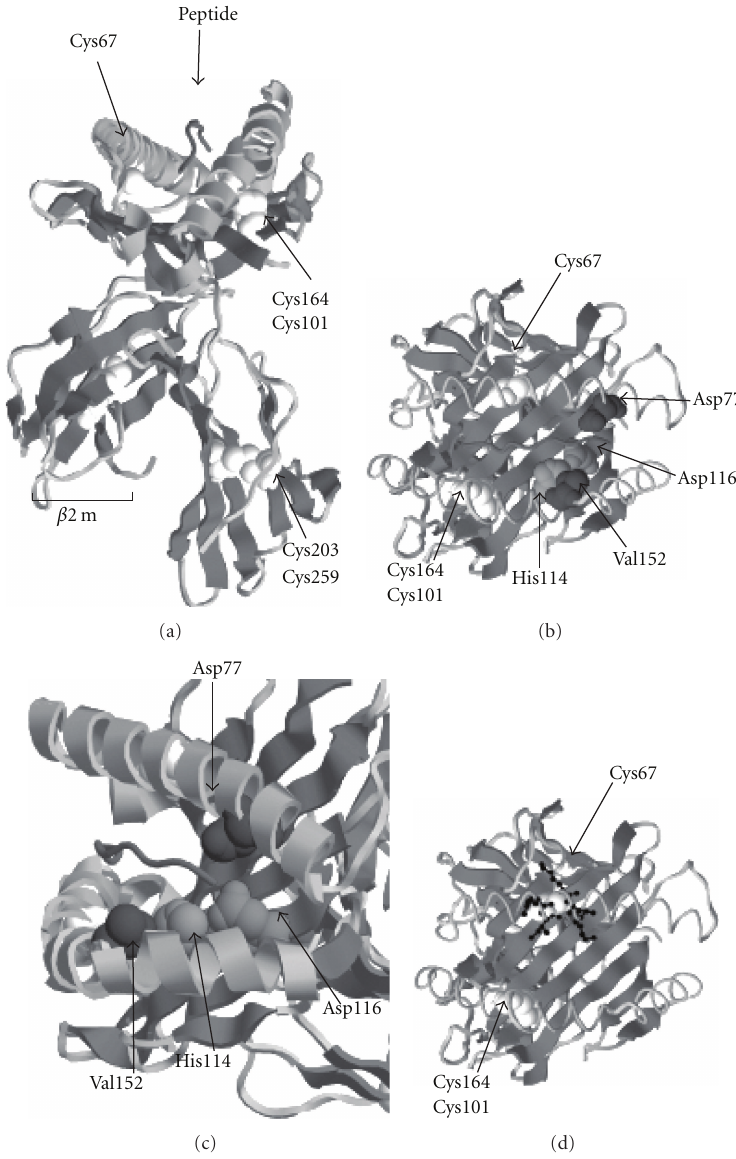
Figure 2: HLA-B27 structure. (a) Ribbon structure of HLA-B27 heavy chain in association with β 2m and peptide. Structurally conserved cysteines at positions 101, 164, 203, and 258 and the unpaired cysteine at p67 are highlighted by Van der Waals radii. (b) Overhead view of the HLA-B27 antigen binding groove highlighting Cys67 and residues (His114, Asp116, Asp77, and Val152) which are polymorphic between the disease-associated HLA-B ∗ 2705 and nondisease-associated HLA-B ∗ 2706 subtypes. (c) Head on view of the F pocket of the HLA-B27 antigen binding groove. His114 and Asp116 make up the floor of the F pocket, whilst Val152 and Asp77 can contribute to the interaction between HLA-B27 and the carboxy-terminus of the associated peptide. (d) Overhead view of the HLA-B27 antigen binding groove, with Cys67 (Van der Waals radii) and surrounding residues (ball and stick) are depicted, which are unique to HLA-B27 and contribute to the B pocket of